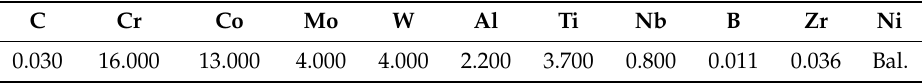
Table 1. Chemical composition of FGH96